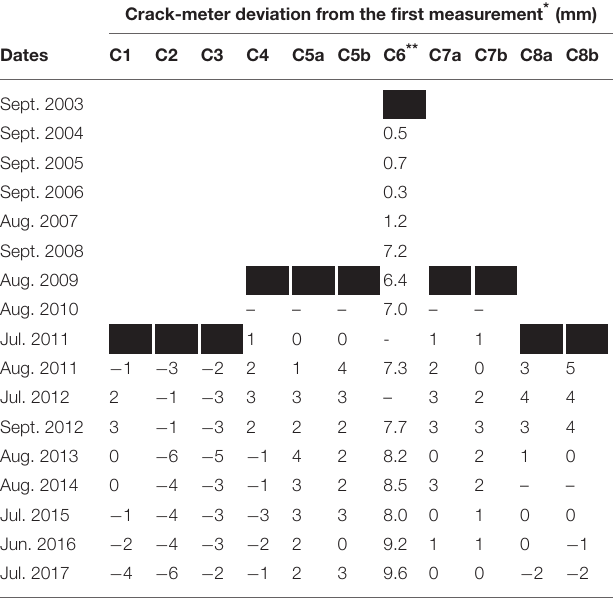
TABLE 2 | Cumulative movement monitored by crack-meters. Crack-meter deviation from the first measurement * (mm)